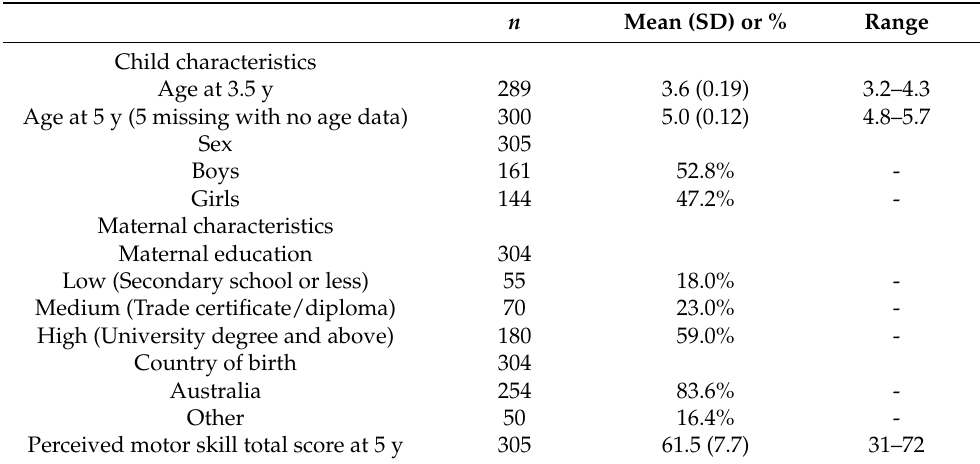
Table 1. Demographic characteristics of the sample (children with any predictors and perception data at 5 y). n Mean (SD) or %